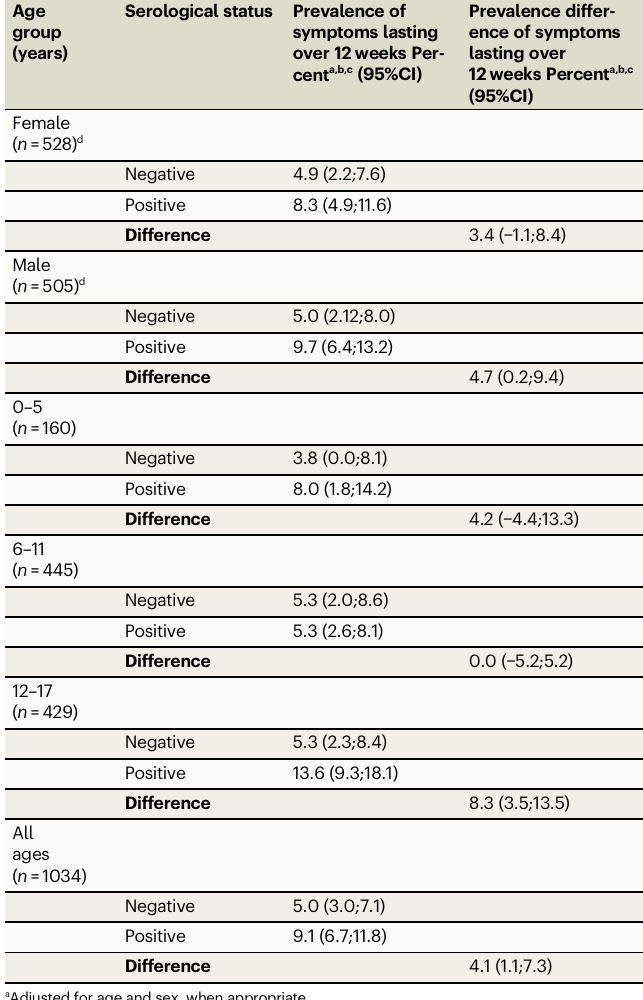
Table 2 | Sex and age- adjusted prevalence and prevalence difference of persistent symptoms Serological status Prevalence of Age symptoms group (years)